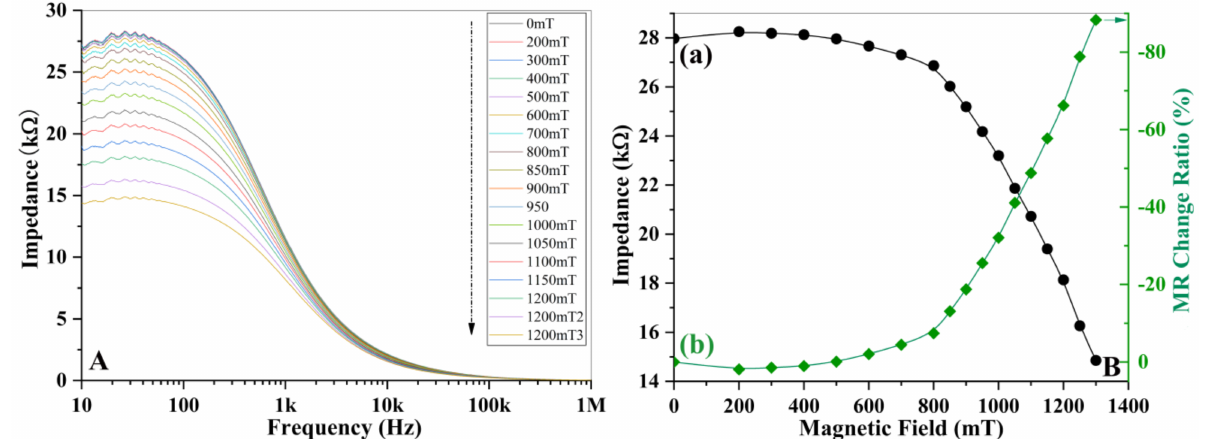
Figure 10. Magnetoresistance effect (MR) in La 0.5 Sr 0.5 Fe 12 O 19 ceramics; ( A ): Change in impedance or resistance with the magnetic field as a function of frequency, ( B ): reduction process of the impedance with the magnetic field (a) and MR change ratio upon different magnetic fields (b). The magnetic field increases from 0mT to 1200 m T at a step of 50 m T, and the magnetic field stays at each stepwise where a full frequency dielectric spectrum was collected using the scanning